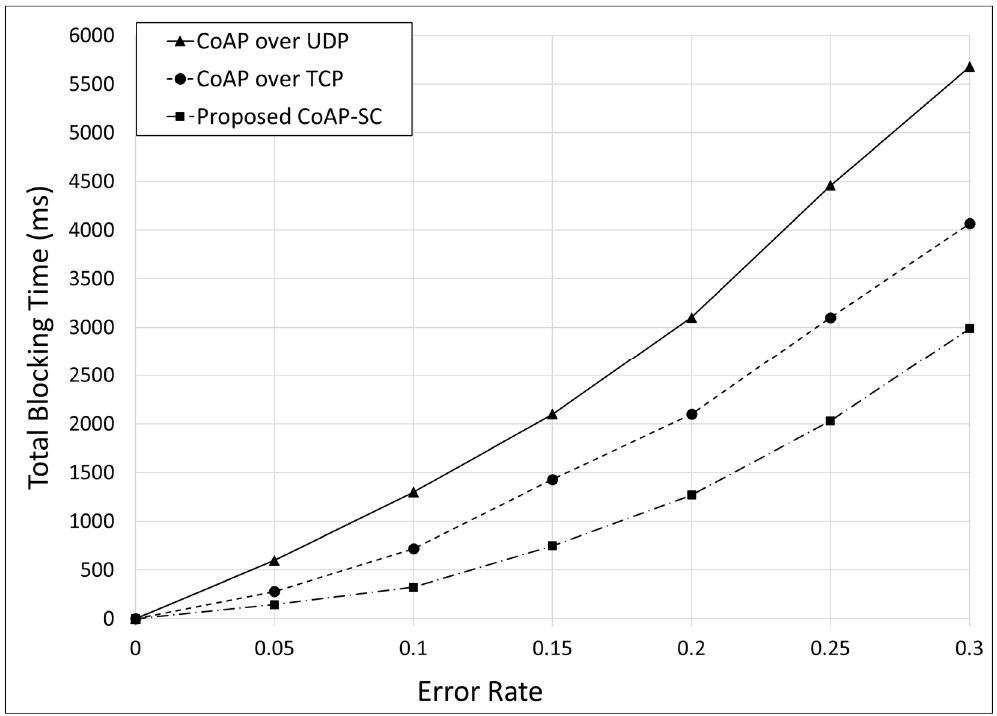
Figure 21. Total blocking time for different error rates.